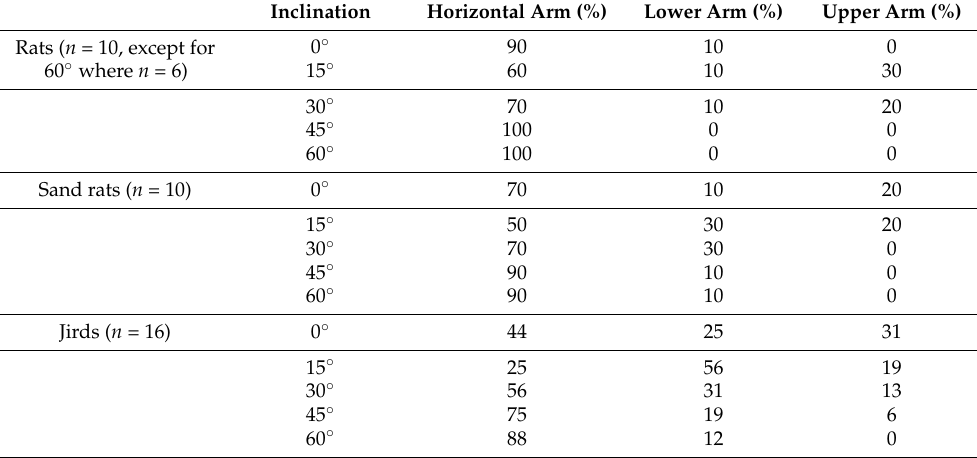
Table 2. The percentage of rodents that established their home-base in each of the arms. The number of rodents in each group is depicted beside the name of each group. For each arm at each inclination, the proportion of animals that established the home-base in that arm is depicted. As shown, there was a strong preference to establish the home-base in the horizontal arm. While at shallow inclinations there were a few rodents that established the home-base at the far end of the inclined arm, in the steep inclination of 45 ◦ and 60 ◦ , the home-base was almost exclusively established in the horizontal arm.